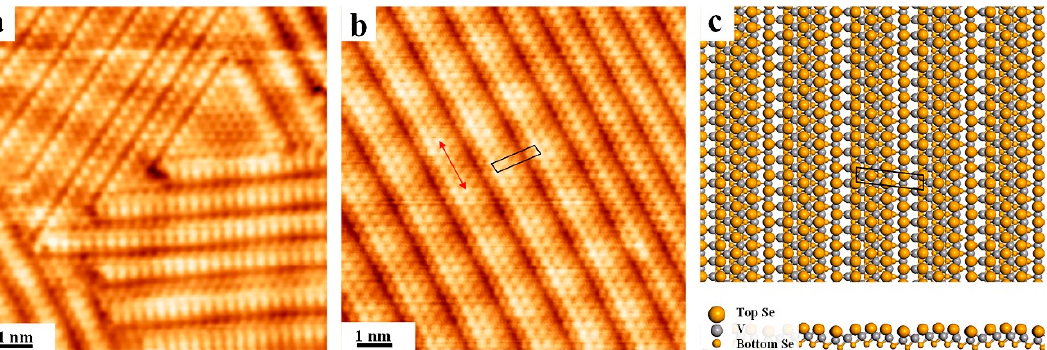
Figure 2. Formation of the streaked structure after annealing the pristine VSe 2 at 450 °C. ( a ) STM image of linear chains with three orientations corresponding to the three-fold symmetry of Au(111). ( b ) Atomically resolved STM of the striped pattern with two different periodicities. ( c ) Configuration for the typical streaked structure from DFT calculations with top and side views. The unit cell is highlighted by the black parallelogram. Scanning parameters: ( a ) U bias = 1.2 V, I t = 5.6 nA; ( b ) U bias = − 1.2 V, I t = 3.0 nA.